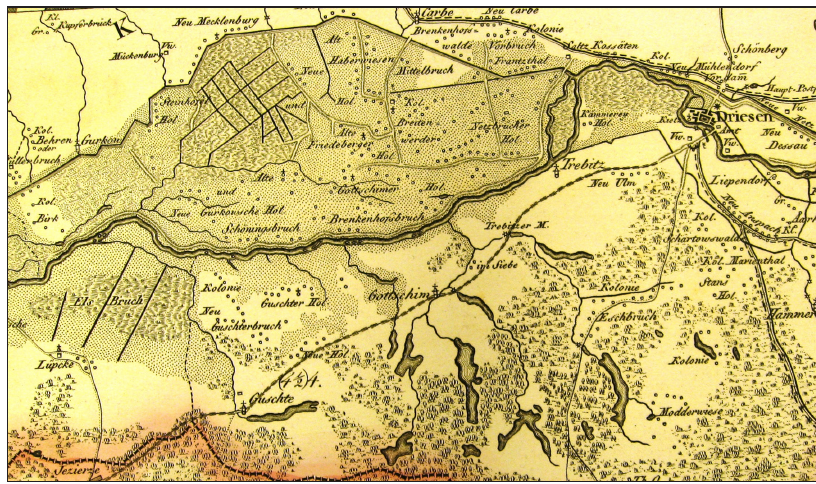
Figure 5: Driesen/Drezdenko (upper right). 1803. Source: Gilly, Special Karte. Quadrant AI. Source: Library of Congress, Geography and Maps Division (G6080 1803